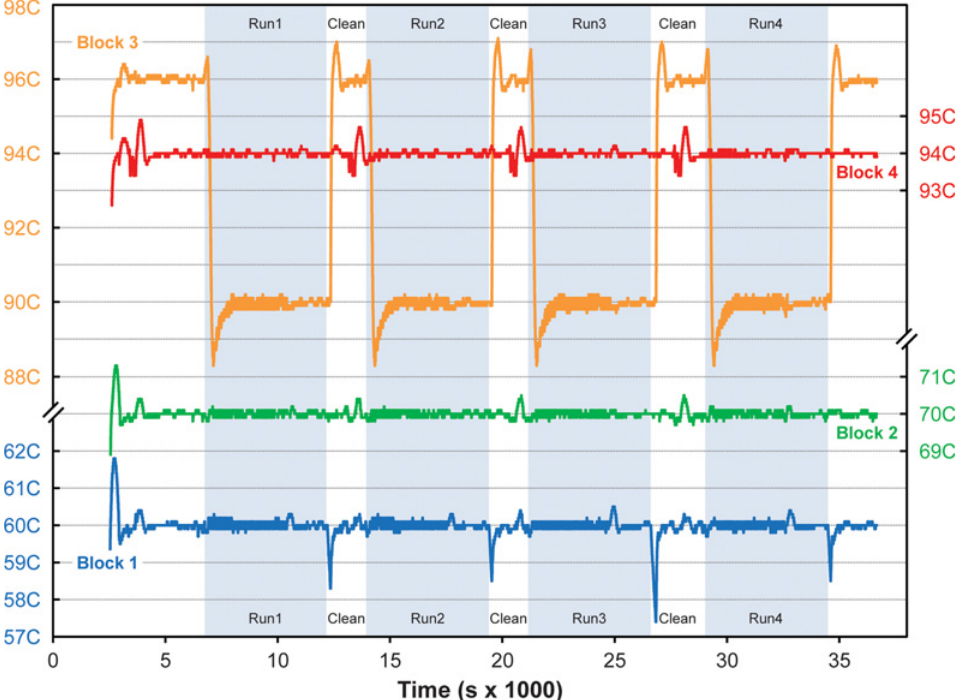
Fig 10. 4-block RZTC temperature history from startup through a series of four PowerPlex 16 HS runs (shaded) with unloading, cleaning, and loading operations between them. Block 3 is switched in real time between 96°C hot start and 90°C cycling